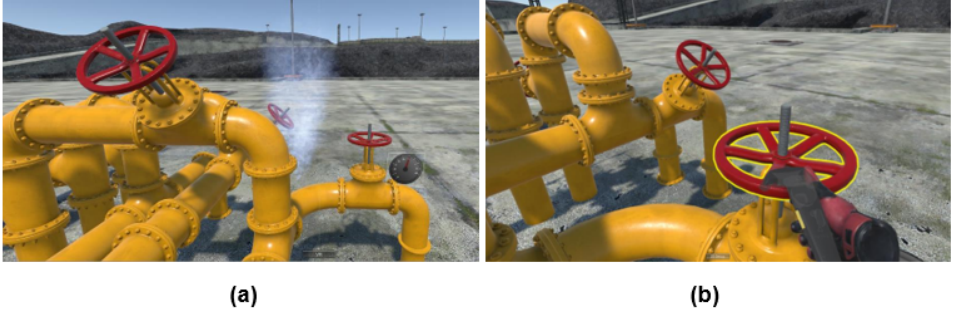
Figure 4. Module 3 Pipeline Valve Rotation: ( a ) Smoke leakage from pipeline. ( b ) Rotating valve using